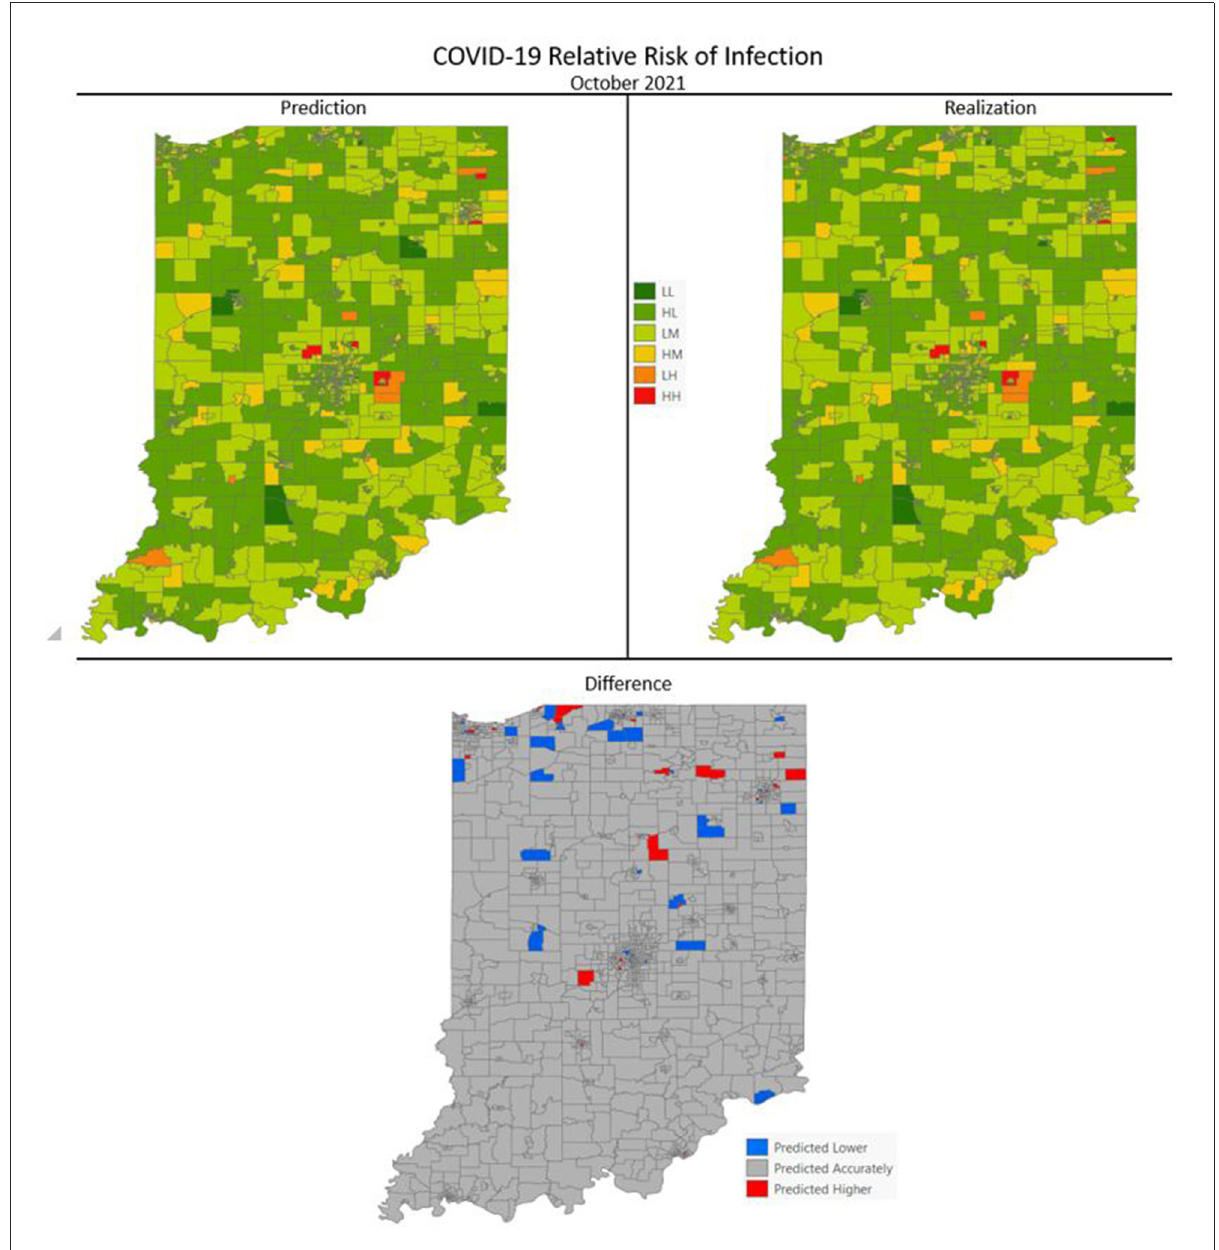
FIGURE7 COVID-19 categorical relative risk of infection prediction and realization for October